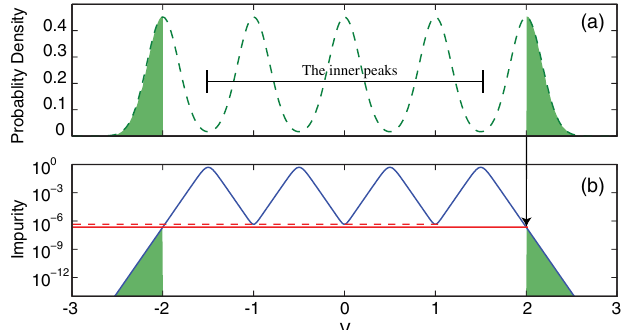
FIG. 20. (a) Probability distribution P ð V; t Þ , Eq. (A6), for D ¼ 5 and t ¼ 4 (cid:2) (cid:2) 1 . The shaded regions of the probability dis- tributioncontain 1 =D of the total probability at long times. (b) The solid blue line is (cid:2) ð V; t Þ ,Eq. (A9), plottedwith a logarithmic scale on the abscissa for D ¼ 5 and t ¼ 4 (cid:2) (cid:2) 1 . The dashed red line is a projection onto the abscissa of the minima of (cid:2) ð V; t Þ at V ¼ (cid:2) 1 ; 0 ; 1 . The solid red line is a projection onto the abscissa of the (cid:2) ð V; t Þ evaluated at V ¼(cid:4) 2 ; notice that this projection is purer than the dashed line. The shaded regions in (b) depict the impurity of records that have j V j (cid:5) J . As these regions concur with the regions in (a), they can be interposed as saying that only a proportion 1 =D of the trajectories will have impurities smaller than those given by the projection (cid:2) ð(cid:4) J; t Þ